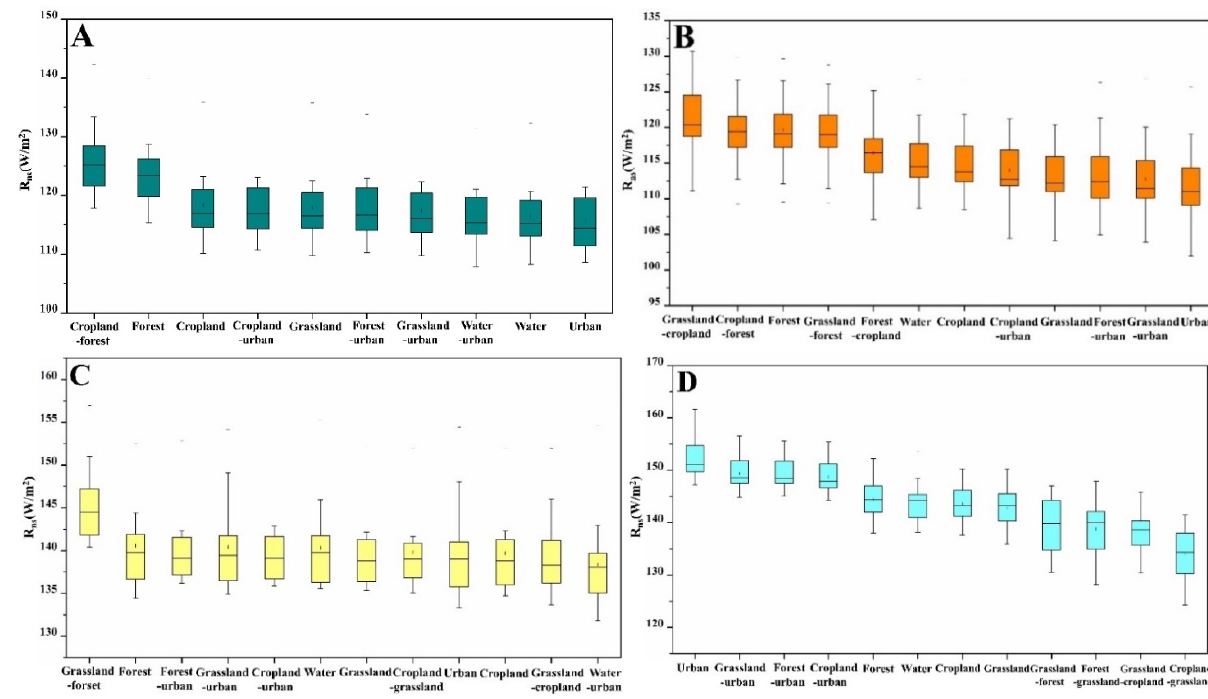
Figure 9. Statistical characteristic values of shortwave radiation based on different land types from 2000 to 2015 (( A ) Jinan City, ( B ) Zhengzhou City, ( C ) Lanzhou City, ( D ) Xining City).